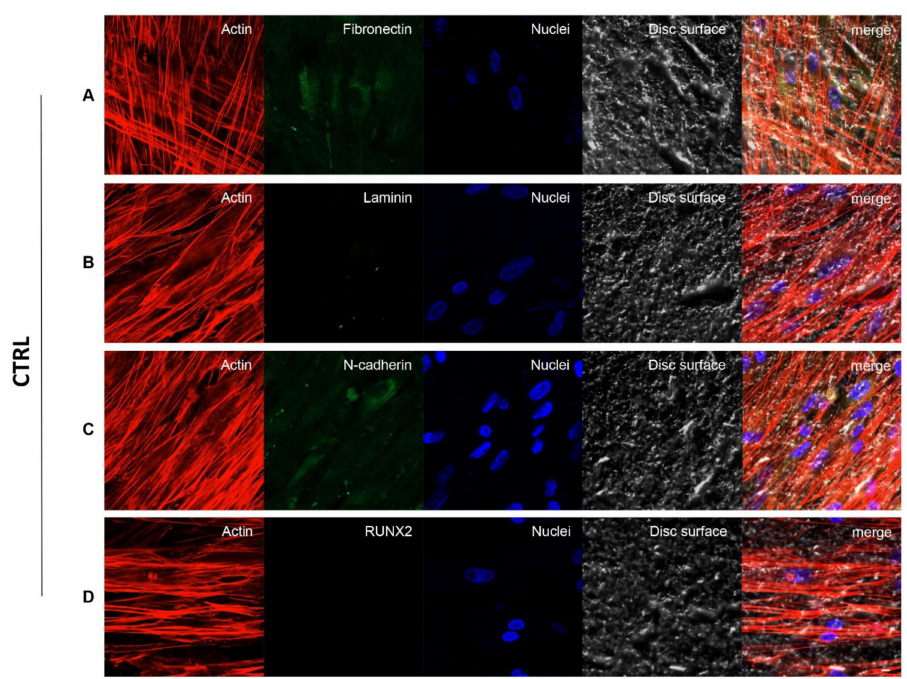
Figure 4. Human PDLSCs cultured on CTRL titanium implant surface were observed after 8 weeks of culture. Cytoskeleton actin was stained in red fluorescence; specific markers ( A ) Fibronectin, ( B ) Laminin, ( C ) N-cadherin and ( D ) RUNX2, were stained in green fluorescence; nuclei were stained in blue fluorescence. This picture was taken from the paper published [14]. Scale bar: 10 µ m.